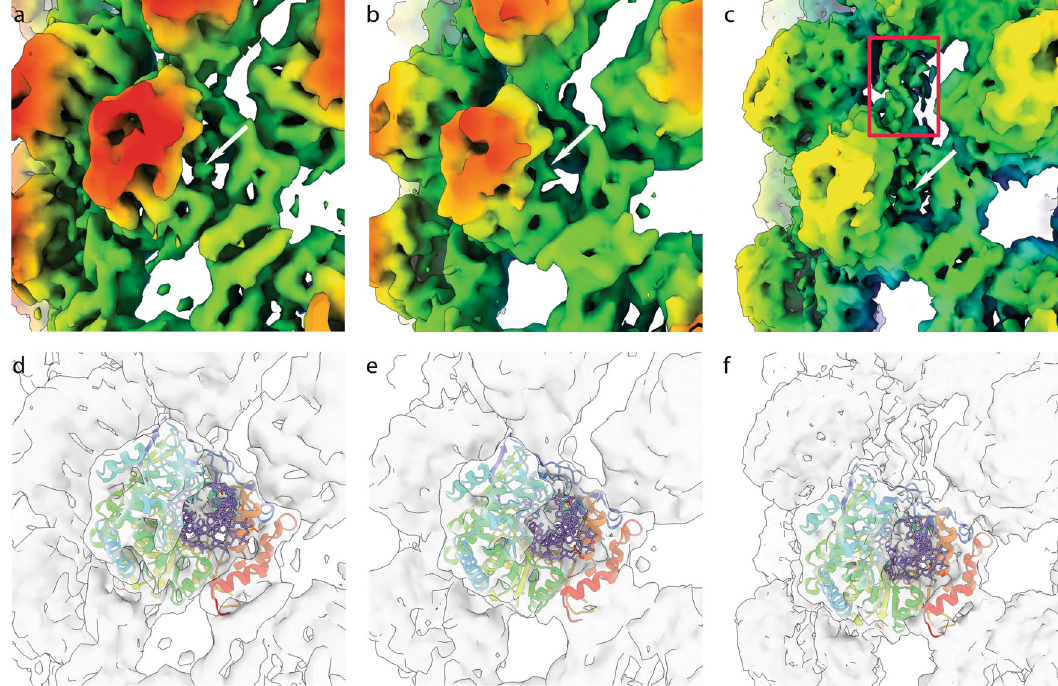
Fig. 8 Unassigned density in fi bril reconstructions indicates the presence of RNA. Close up views of 3D pol reconstructions for fi bril B1 a and N3 b zoomed into a single monomer and coloured according to the radius (key as in Fig. 4f), shows the presence of weak unassigned density in the active site of 3D pol that we attribute to RNA (white arrows). d, e the same view is presented as a transparent isosurface with PDB 2EC0 shown. The atomic model is shown with protein represented as a rainbow coloured ribbon diagram and RNA as sticks coloured mauve, to highlight the assignment of protein and RNA to cryo-EM density. c, f Conformation N9 also shows unassigned density in the active site as well as a fi nger of density linking two proto fi laments (red rectangle) that may be RNA template or product extruded from the active